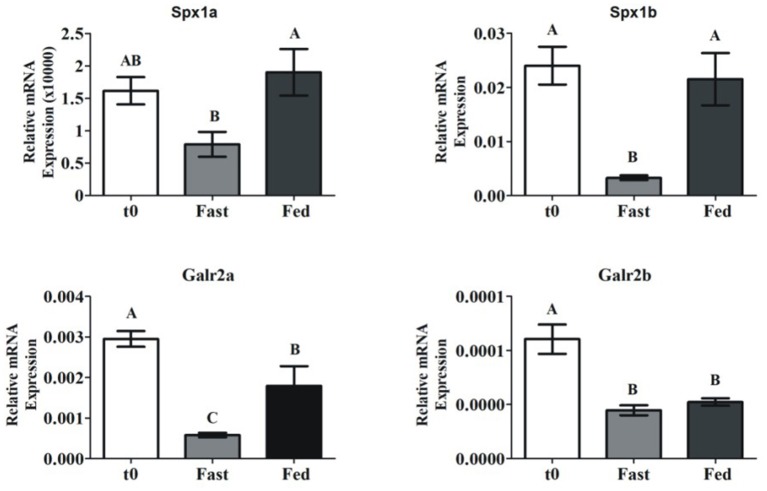
Brain spexin and Galr mRNA expression in response to fasting. Sexually mature tilapia were fed ad libitum (Fed), or fasted (Fast) for 26 days. Results were normalized to the amount of 18S by the comparative cycle threshold method. N = 24. Values are given as mean relative expression ± SEM. Different letters indicate significant differences between groups (p <0.05).